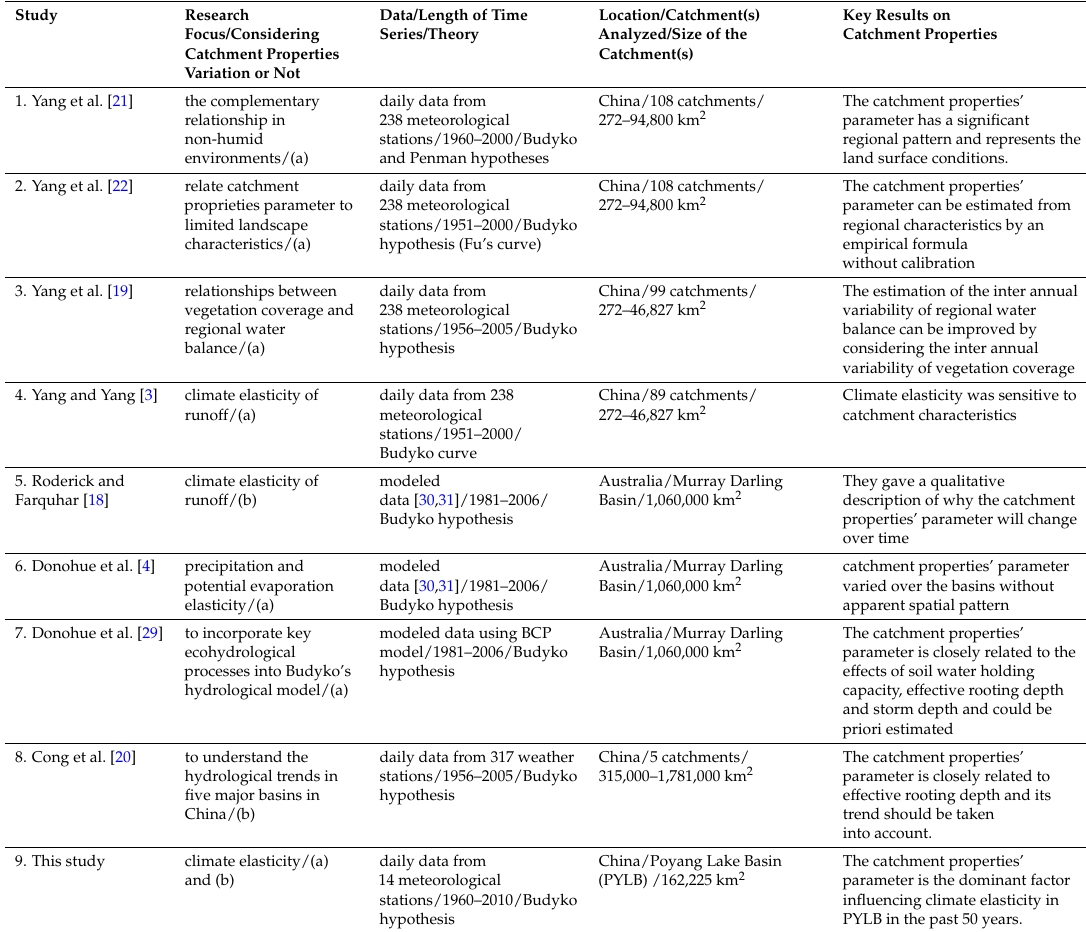
Table 1. Summary of the relevant literature on the climate elasticity of runoff studies based on the Budyko hypothesis in relation to the aims of the present study. In the second column, the consideration of the catchment properties’ parameter is identified by the code: (a) consider the spatial variation of the parameter over different catchments; (b) consider the temporal variation of the parameter. We add the current study for